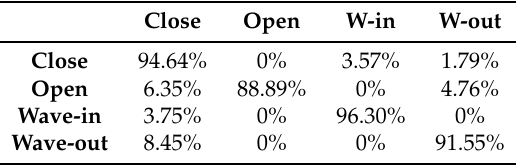
Table 4. Confusion matrix for the SVM classifier: Testing (accuracy: 92.62%).